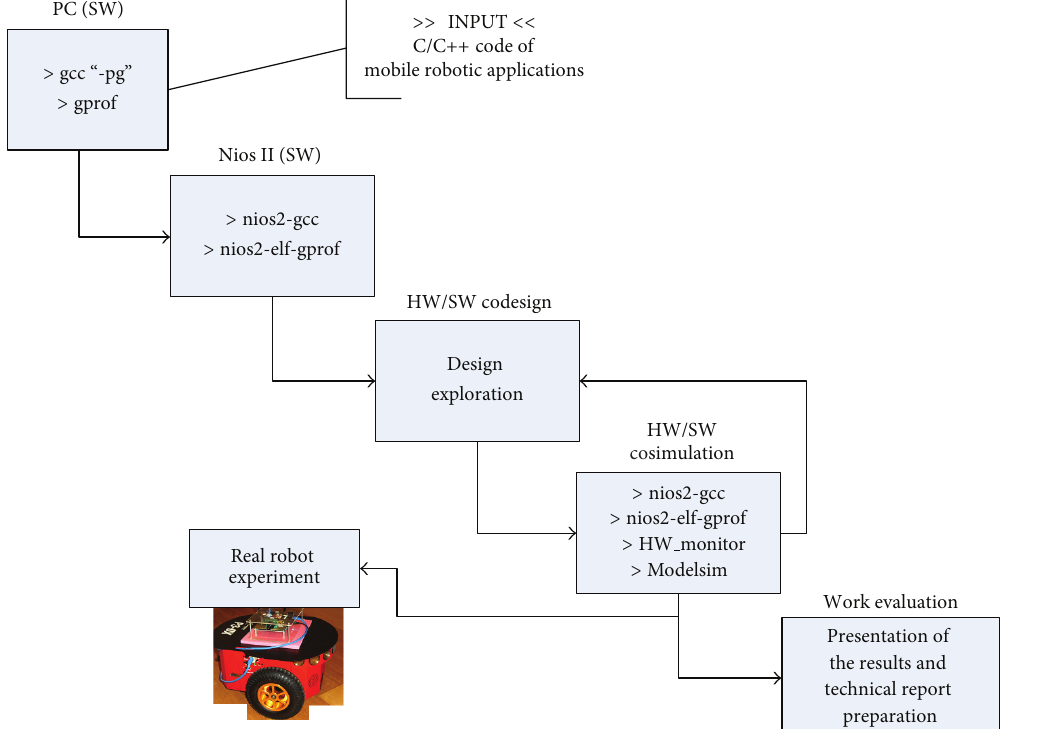
Figure 1: Embedded system development flow adopted by